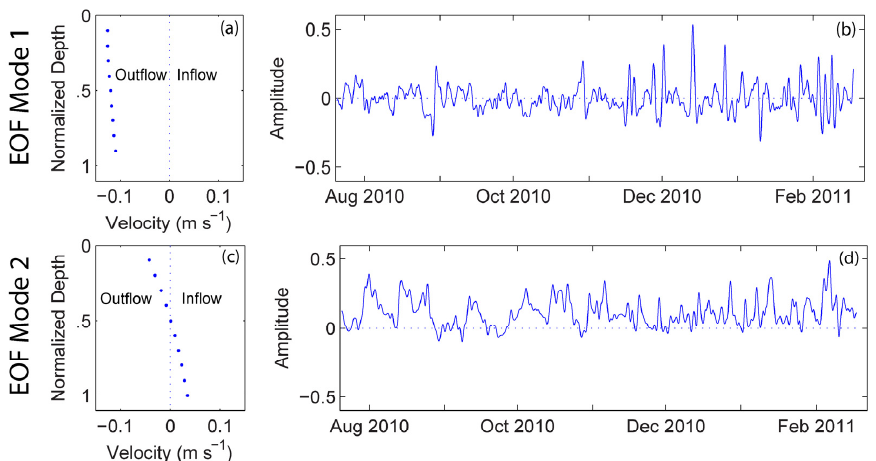
Figure 3. Vertical distributions of EOF eigenvectors ( a , c ); and principal component time series ( b , d ) for EOF modes 1 and 2 at Cocodrie. Positive eigenvector values indicate landward flow; negative values indicate seaward flow.